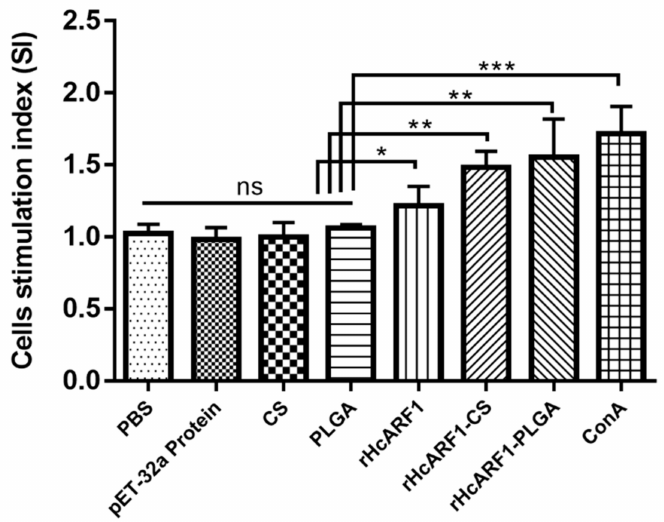
Figure 5. Lymphocyte proliferation was evaluated in all groups of mice by lymphocyte proliferation assay. The result was presented in the form of the stimulation index (SI). The data are representative of three independent experiments and the values presented here are the means ± SEM (* p < 0.05, ** p < 0.01, *** p <